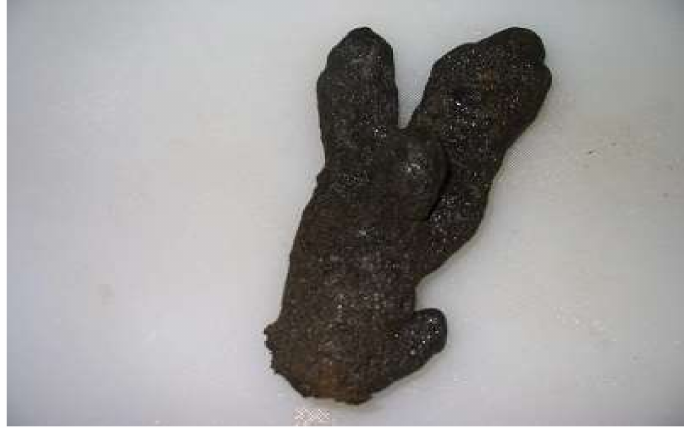
Figure 1. Red Sea sponge Hyrtios erectus (morphology before methanol